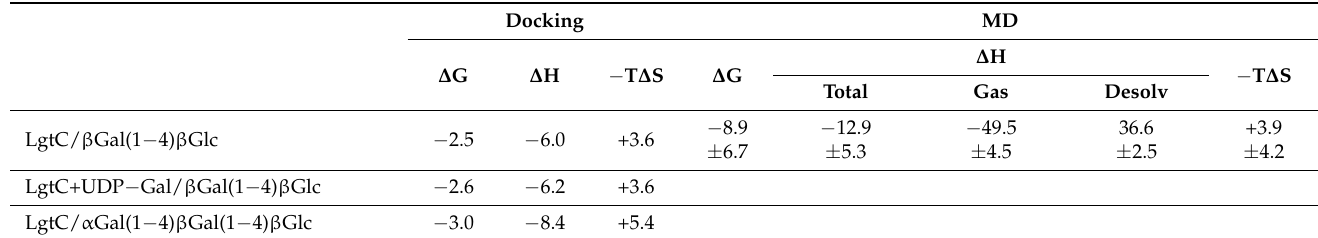
Table A1. Thermodynamic parameters of LgtC binding to its ligands calculated using molecular docking and molecular dynamics (all values are in